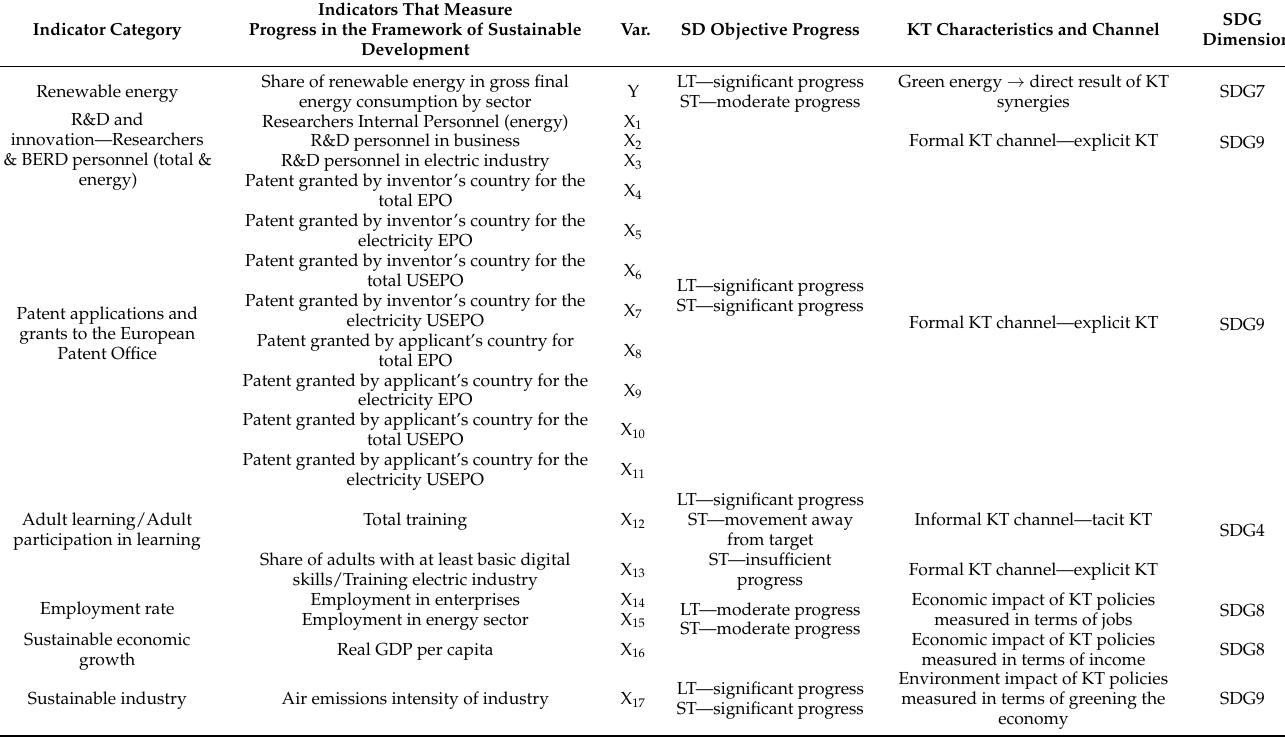
Table 2. Description of research